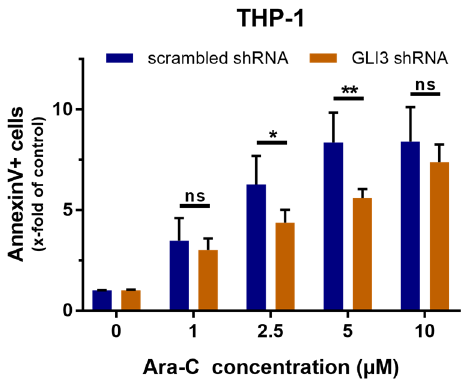
Figure 5. GLI3 knockdown suppresses apoptosis induction upon treatment with Ara-C. THP-1 cells transduced with GLI3-targeted shRNA or scrambled shRNA control were treated with the indicated concentrations of Ara-C, and induction of apoptosis was measured after 48 h by flow cytometry using Annexin V and propidium iodide. In the untreated (control) samples, the majority of cells transduced with scrambled shRNA (Ø 5.9% Annexin V-positive) or GLI3 shRNA (Ø 6.9% Annexin V-positive) were viable. Representative flow cytometry plots are shown in Figure A4 (Appendix A). Error bars represent the mean values ± standard deviation; * p < 0.05, ** p < 0.01 in the Welch’s t -test; ns, statistically not significant.